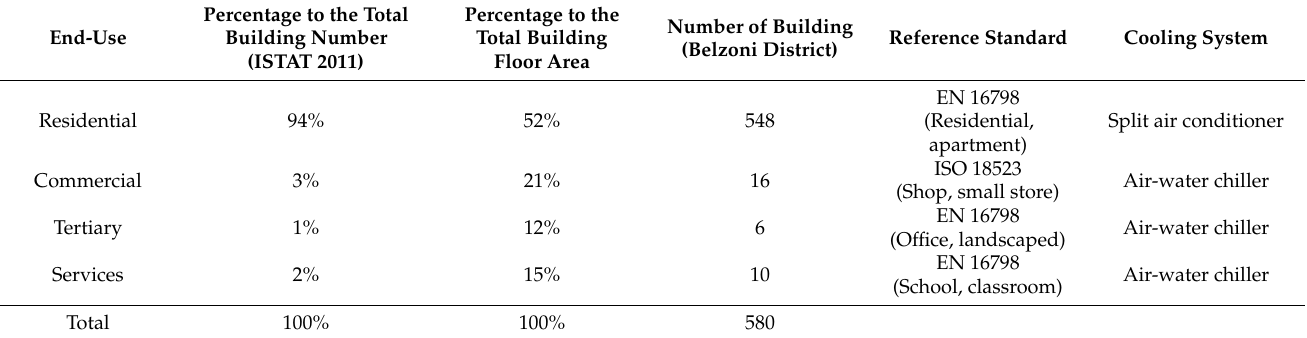
Table 3. End-use percentage distribution of the Padua municipality and number of building.